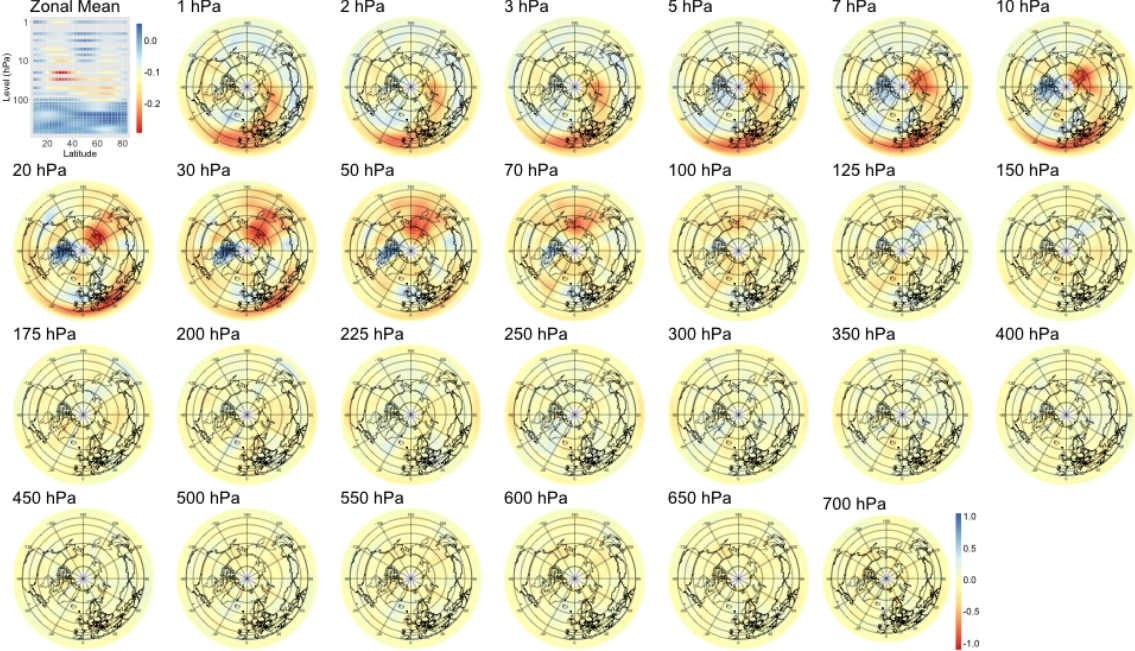
Figure B12. Patterns of heat flux maximizing correlation with the SSW index at a lead time of 14d. The upper-left plot displays the patterns’ zonal